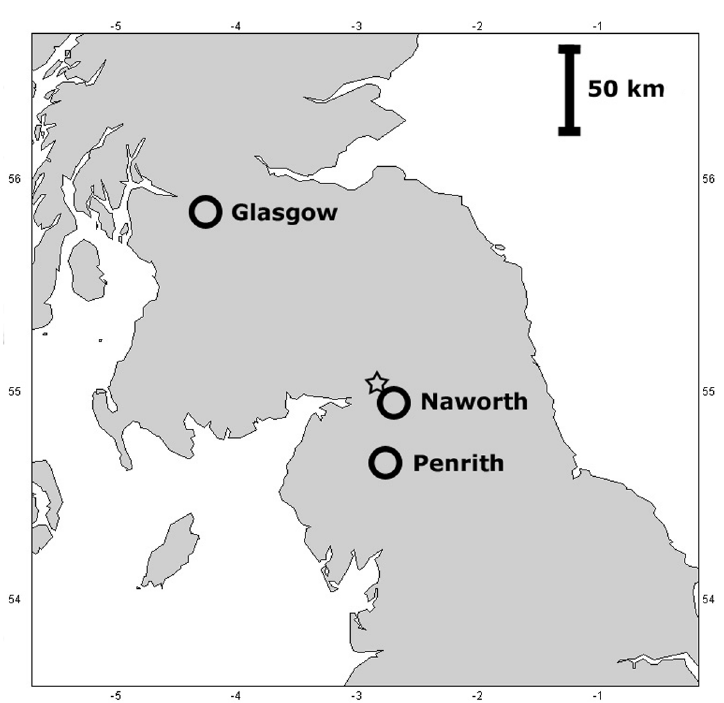
Fig. 4. Places mentioned in connection with the 11 April 1650 earthquake. The star indicates the epicentre of the 1979 Carlisle